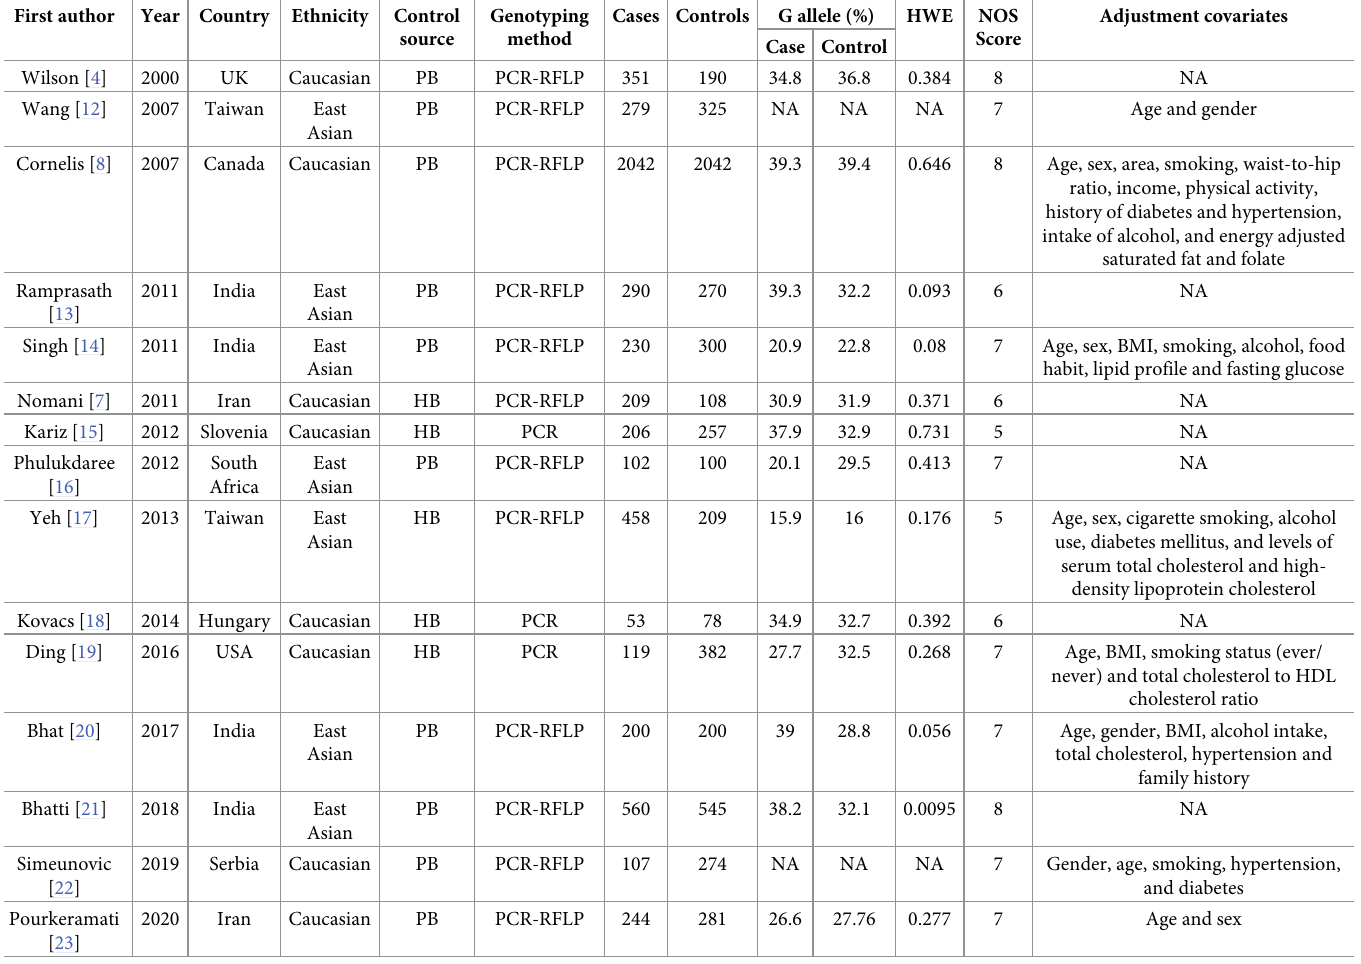
Table 1. Characteristics of studies included in the